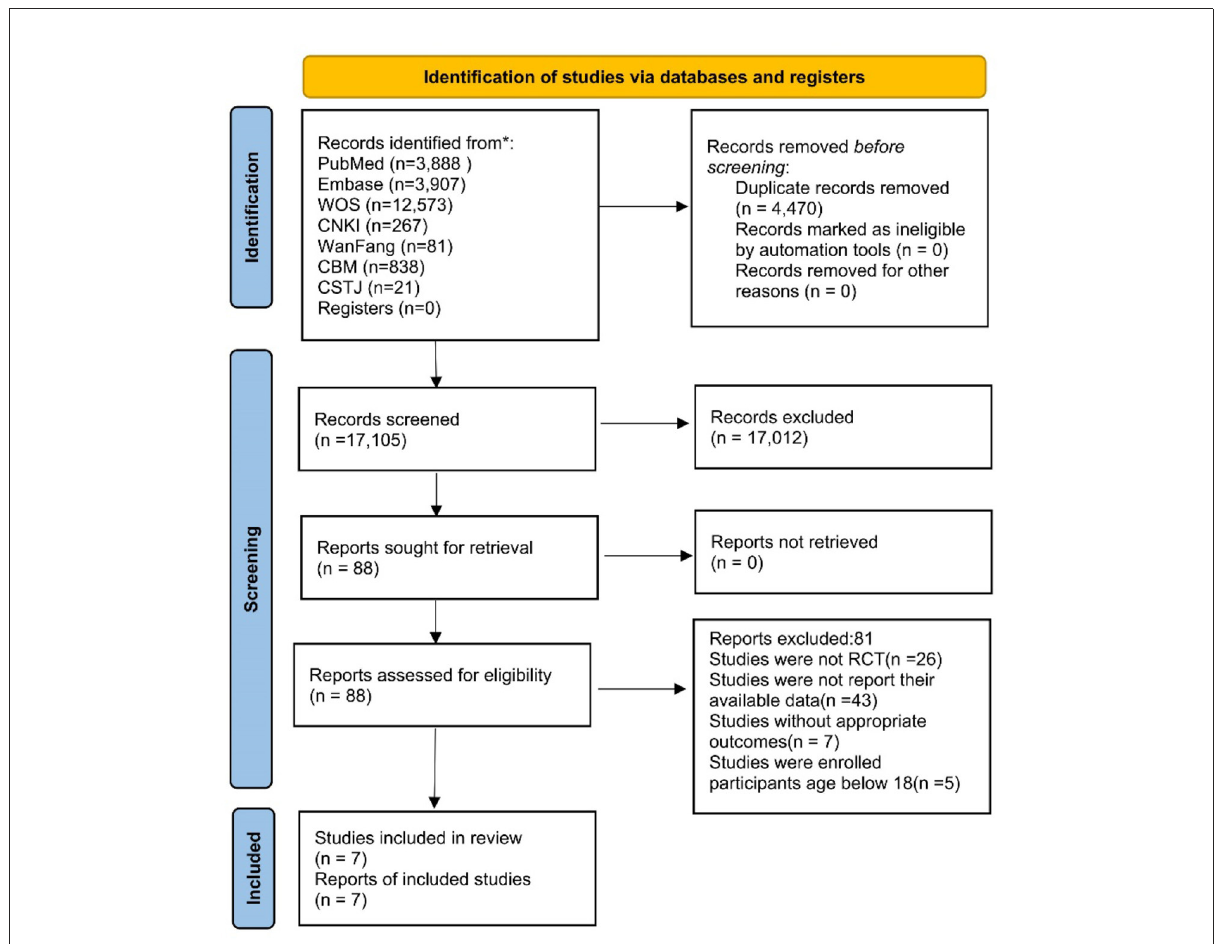
FIGURE1 Literature review flowchart. CNKI, China national knowledge infrastructure; CMB, Chinese biomedical; CSTJ, China science and technology journal; WOS, web of